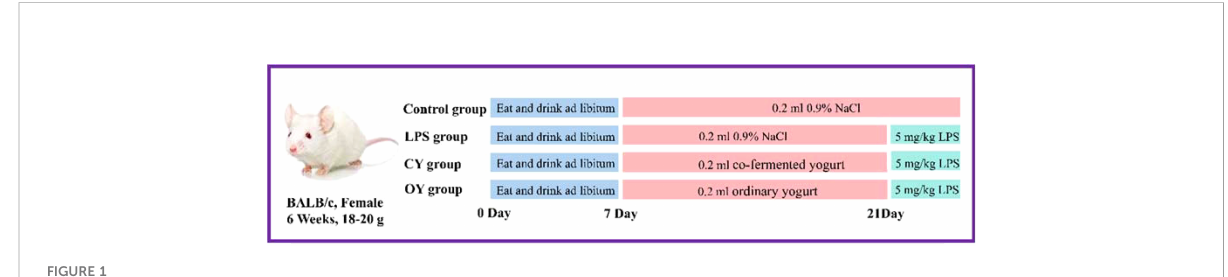
FIGURE 1 Animal model experimental